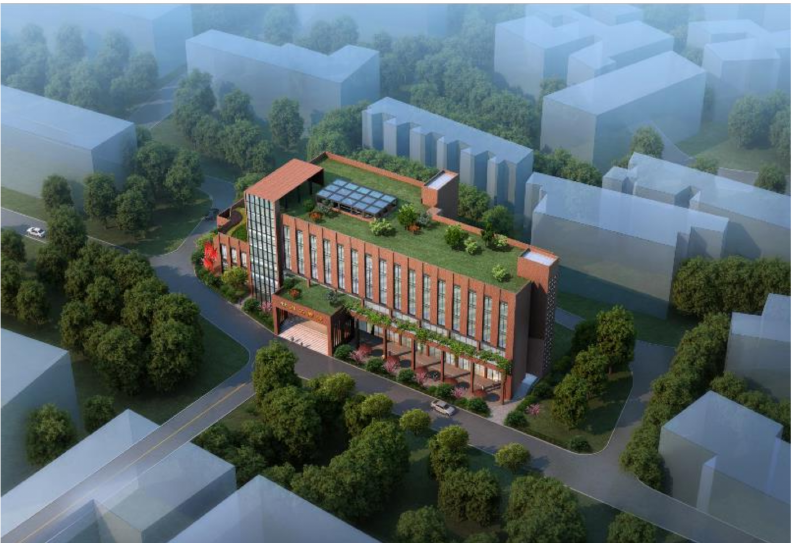
Figure 3. Aerial view of the